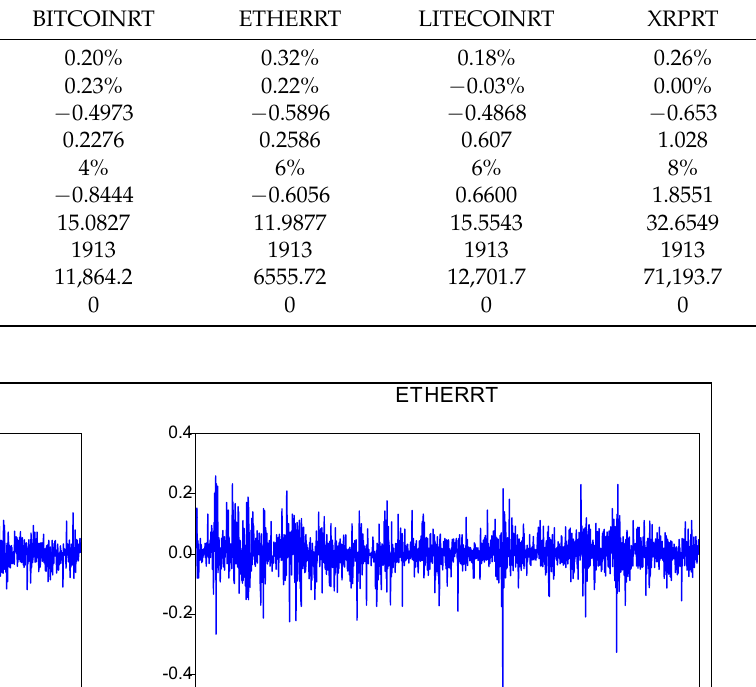
Table 2. Descriptive Statistics of Cryptocurrencies.